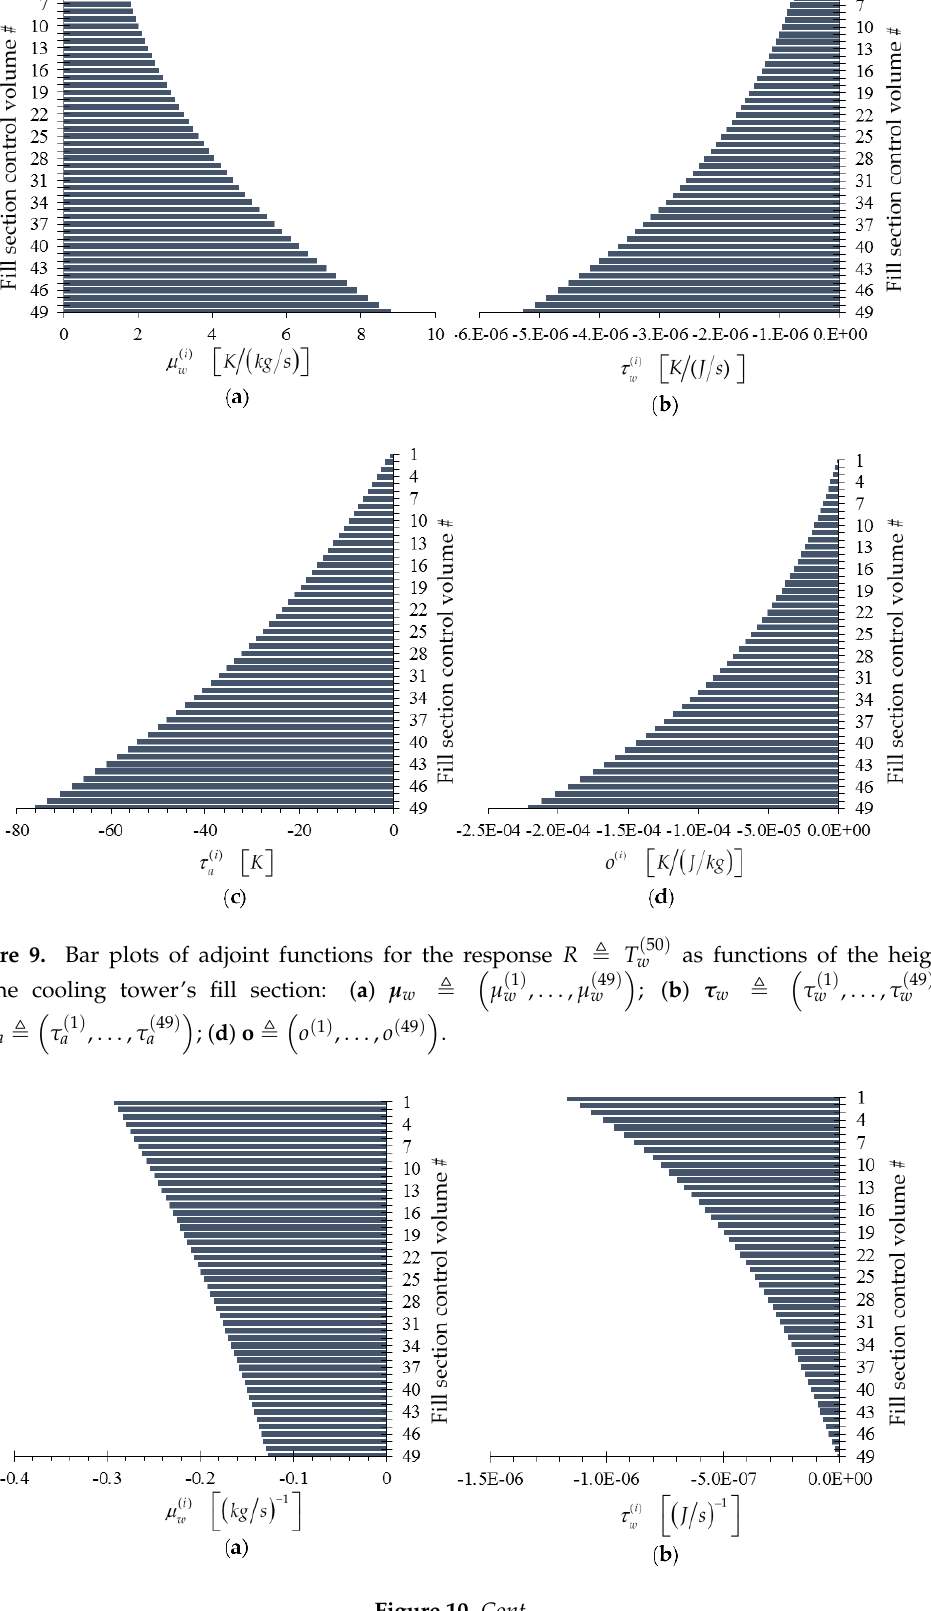
Figure 10. Cont Figure 10. Cont . Figure 10. Cont .